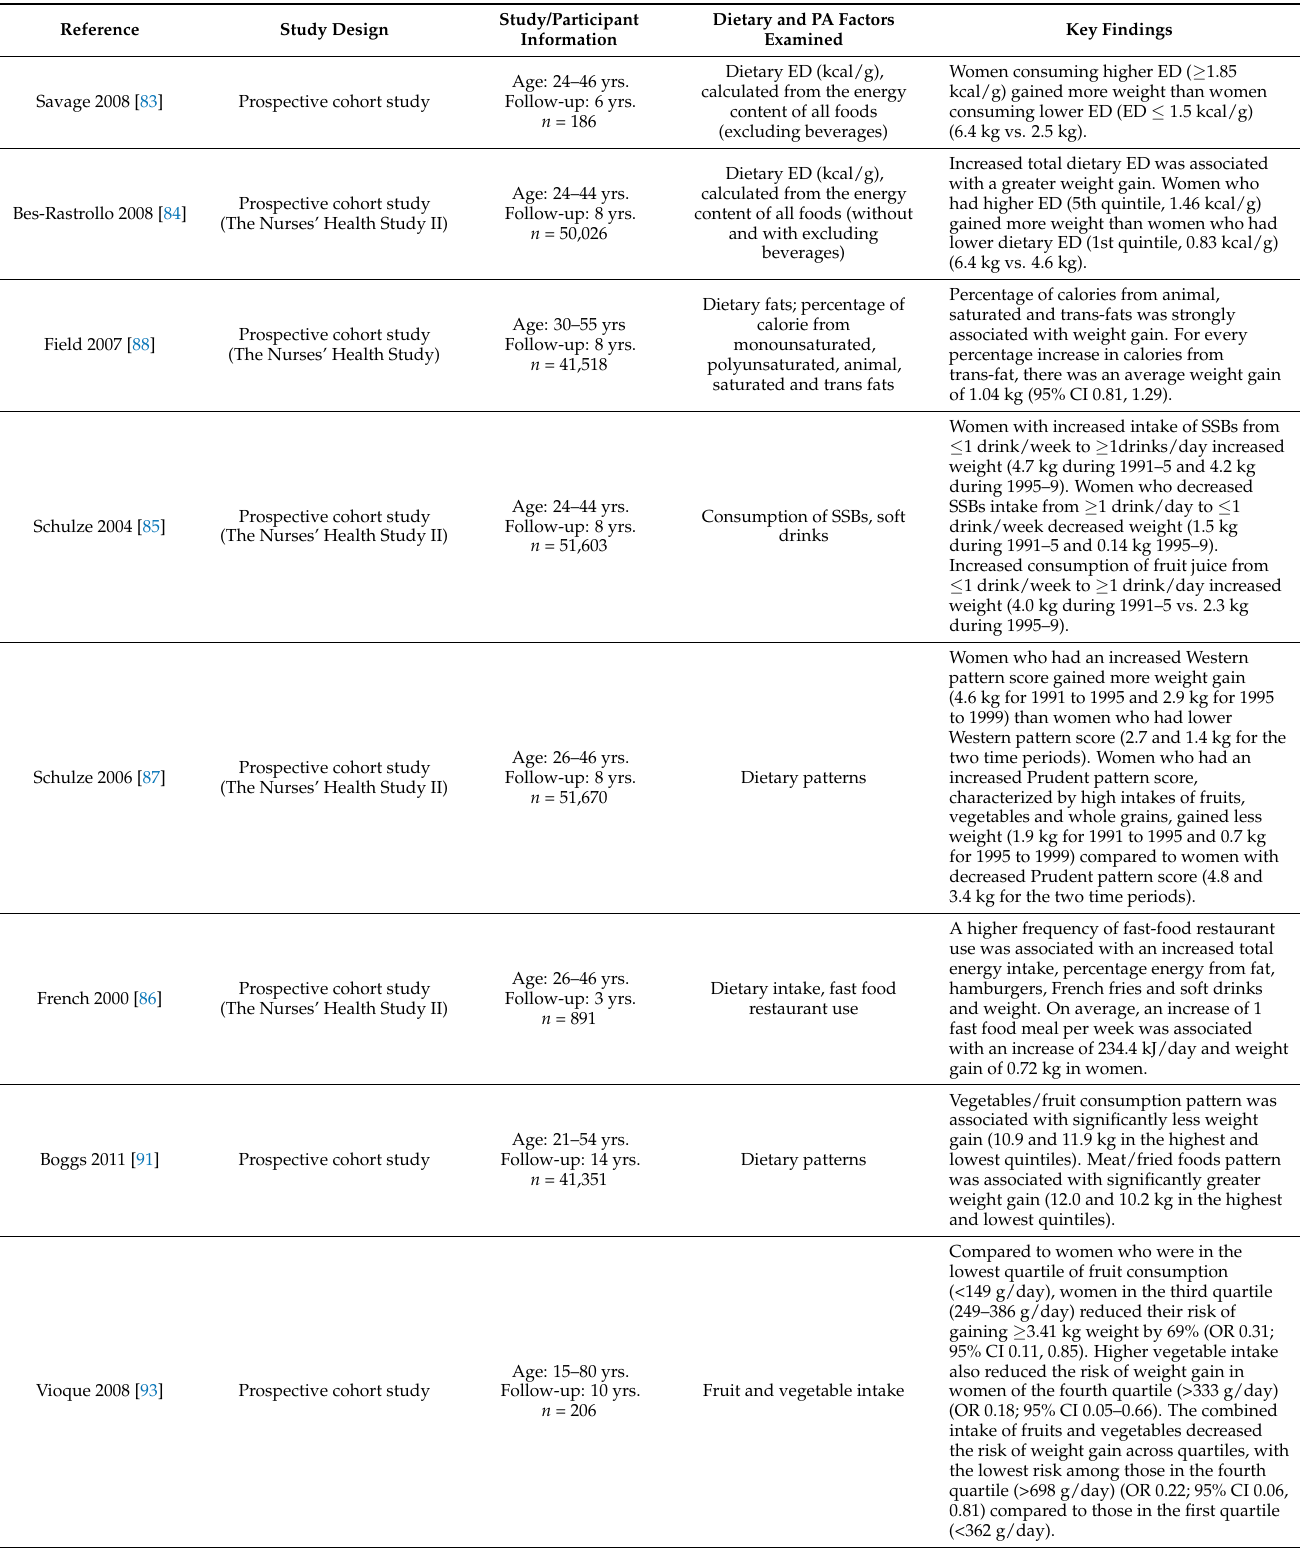
Table 1. Summary of studies that assessed diet, physical activity and weight gain in reproductive-age